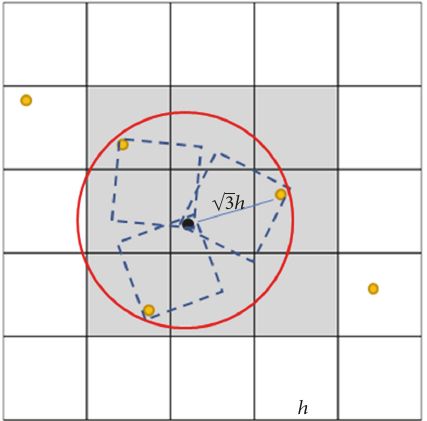
Figure 3: Two-dimensional representation for considering possible collisions between debris residing in neighbouring